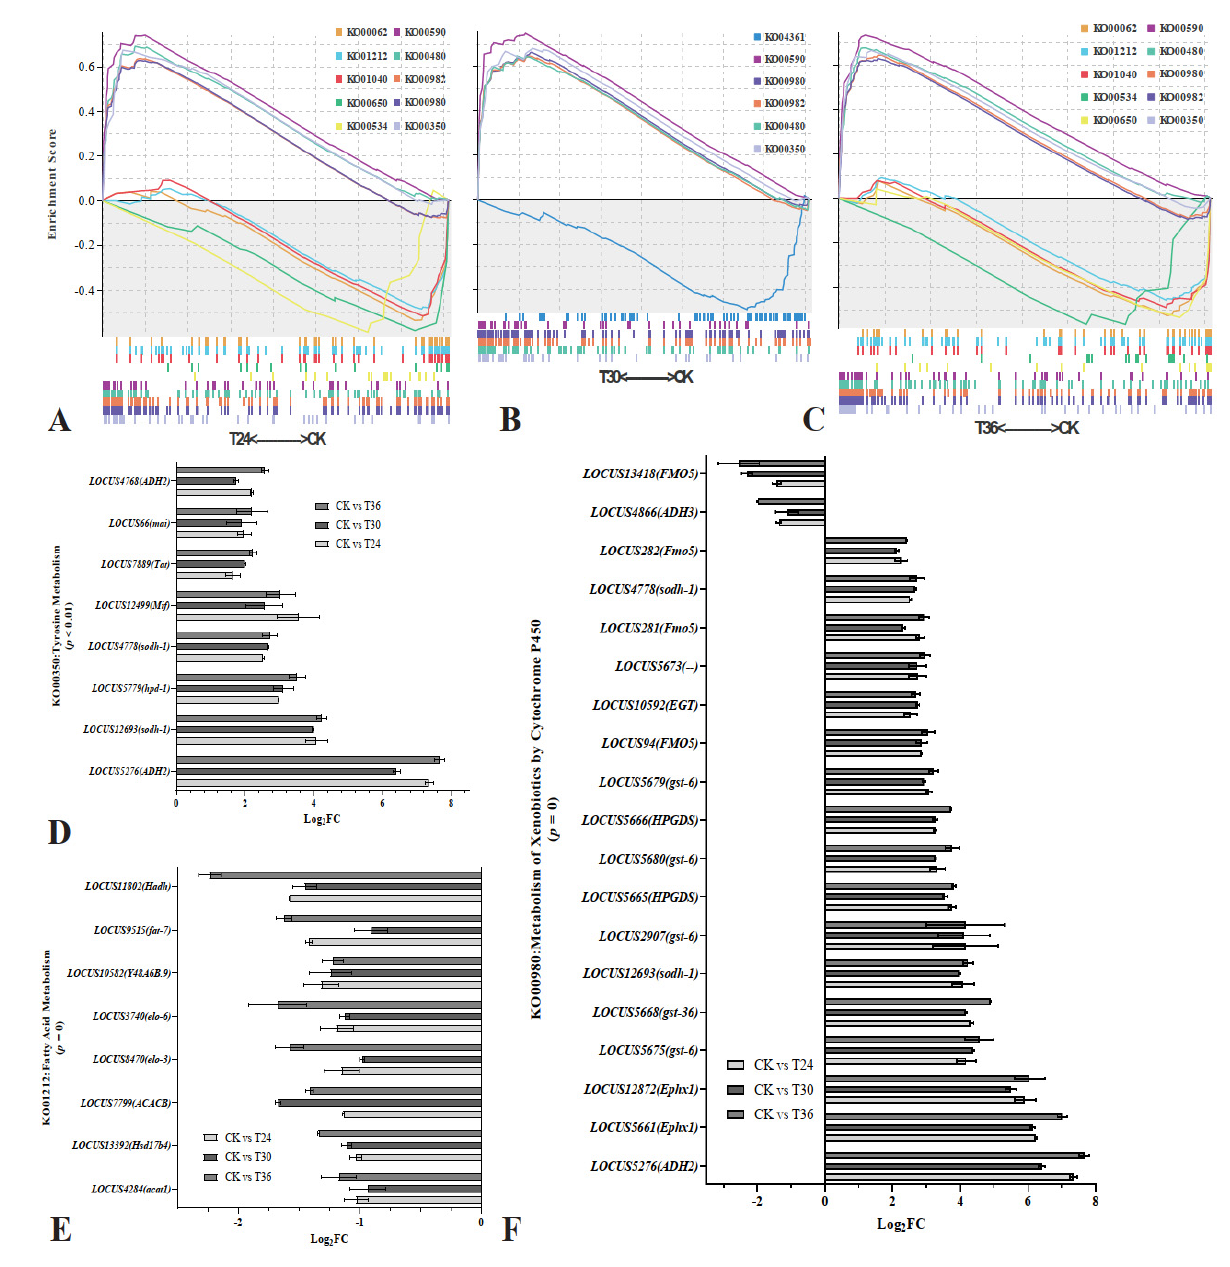
Figure 5. Gene set enrichment analysis (GSEA) of DEGs by KEGG. ( A ) GSEA of CK vs. T24 by KEGG; ( B ) GSEA of CK vs. T30 by KEGG; and ( C ) GSEA of CK vs. T36 by KEGG. NOM p < 0.05; FDR q < 0.05. ( D ) KO00350 pathway gene expression levels in RNA-seq; ( E ) KO01212 pathway gene expression levels in RNA-seq; and ( F ) KO00980 pathway gene expression levels in